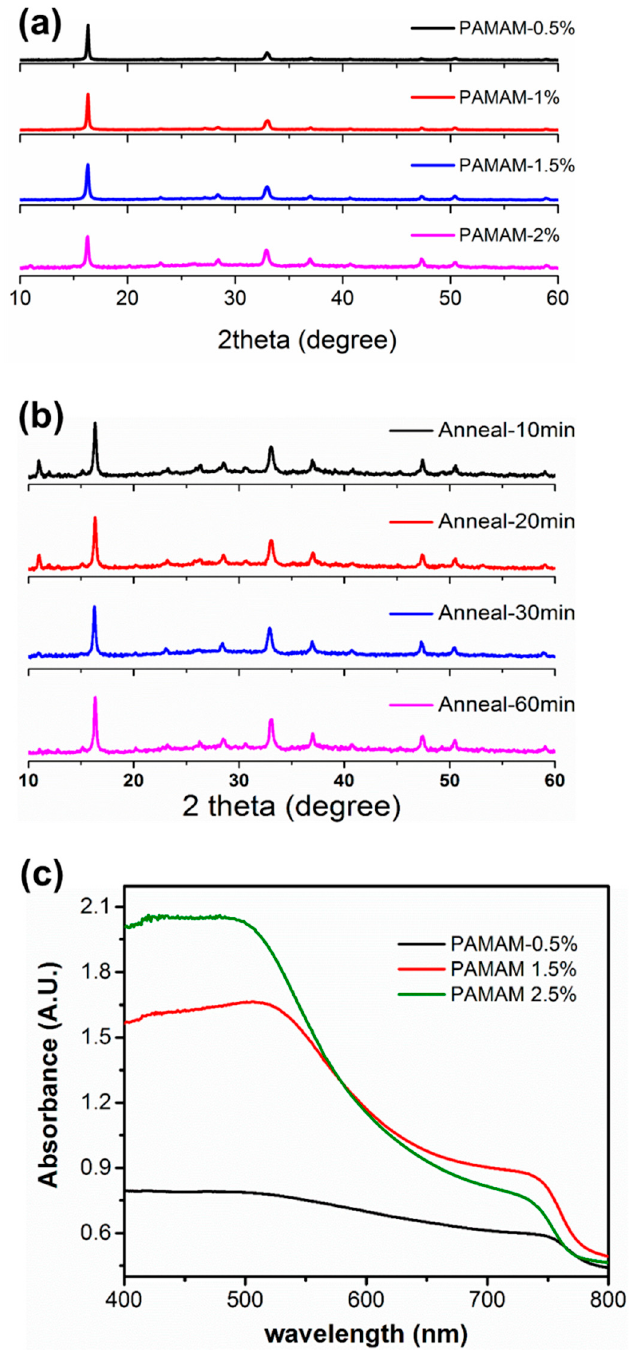
Figure 1. ( a ) XRD patterns of perovskite thin films with different weight percentages of PAMAM dendrimers (annealing at 100 °C for 60 min); ( b ) XRD patterns of perovskite thin films with 1 wt% of PAMAM at 100 °C for different annealing times; ( c ) UV-Vis spectra of perovskite thin films with PAMAM loading of 0.5%, 1.5%, and 2.5% in weight.